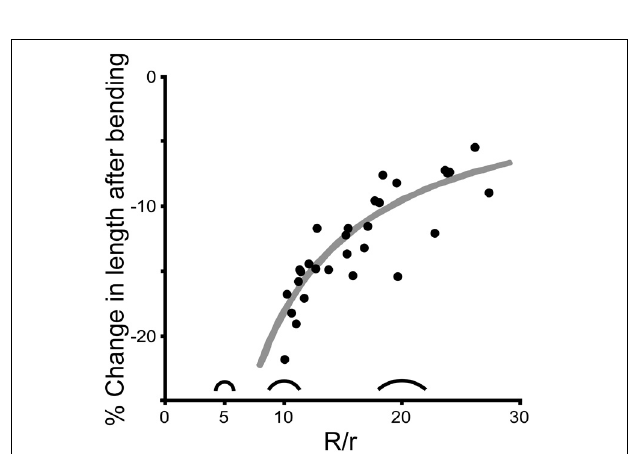
FIGURE 7 | Change in length after bending. Lengths of the experimental sections of antennae were calculated for both the convex and concave sides of each antenna by summing the digitized lengths of the adjacent flagellomeres before bending, after bending (“bent”), and after re-straightening (“re-straightened”). The percent change in length is calculated relative to the length of the initial (straight) section before bending. Data have been combined for both sexes and all four directions of bending because they are not significantly different from each other ( n = 29 bending measurements, n = 15 antennae, each antenna bent in two directions, mean ± 2 s.e.m.).